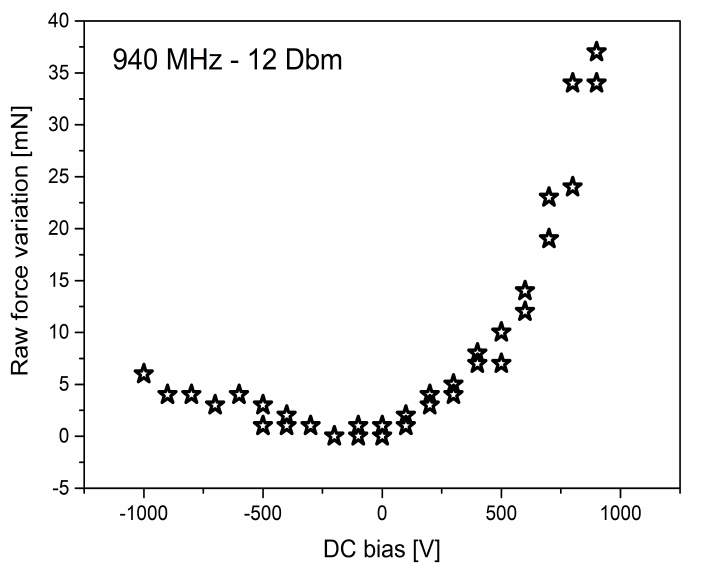
Figure 9. Effect of the high voltage DC bias on the force variations while the RF field is kept on at the frequency and power indicated in the inset. Here, the device is oriented as in Figure 2. The voltage was varied from − 1 kVolt to 1 kVolt and backwards, with steps of 100 volts, completing a full hysteresis loop. The indication of raw force variation is due to the fact that data are untreated to compensate for any eventual thermal